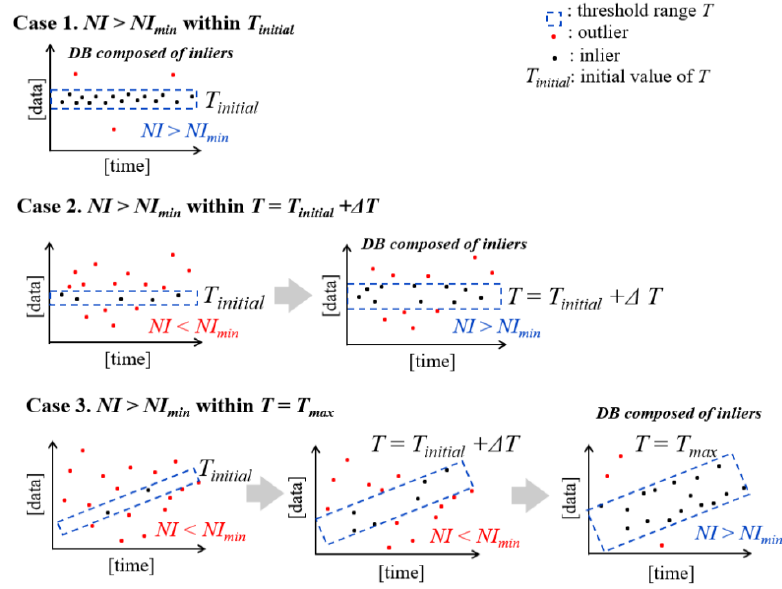
Figure 4. The inliers determination based on the variable T range.